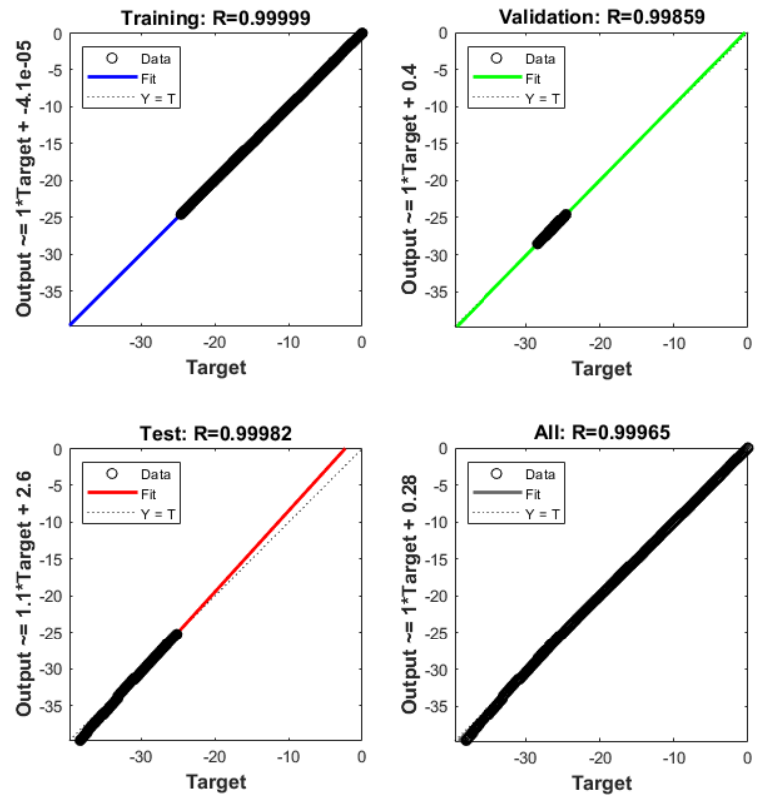
Figure 28. Regression in neural model identification. Table 5. The target values.